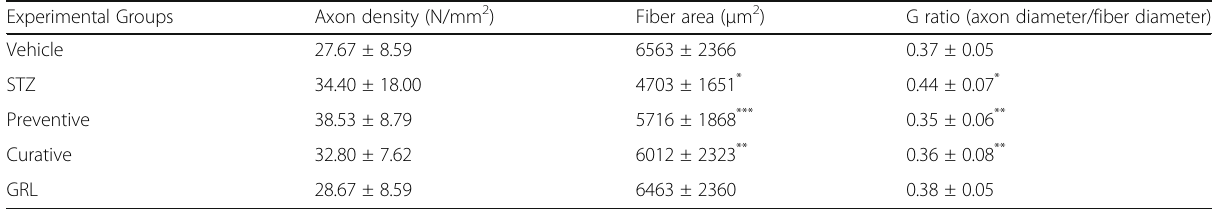
Table 4 Morphometric analysis of the sciatic nerve at the end of the 8th week Experimental